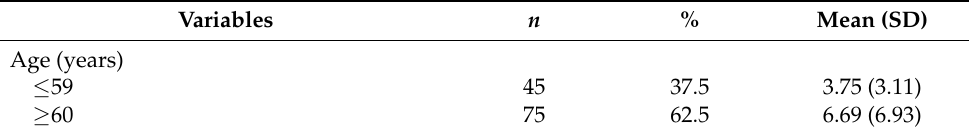
Table 1. Sociodemographic characteristics of patients on hemodialysis ( n =